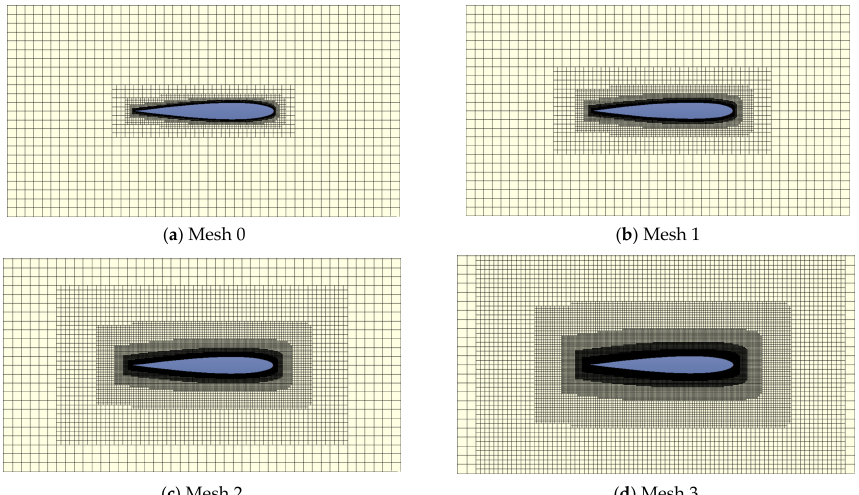
Figure 4. Comparison of four sets of grids with different mesh refinement schemes. ( a ) Each grid layer’s refinement is 2 layers; ( b ) each grid layer’s refinement is 4 layers; ( c ) each grid layer’s refinement is 8 layers; ( d ) each grid layer’s refinement is 12 layers.